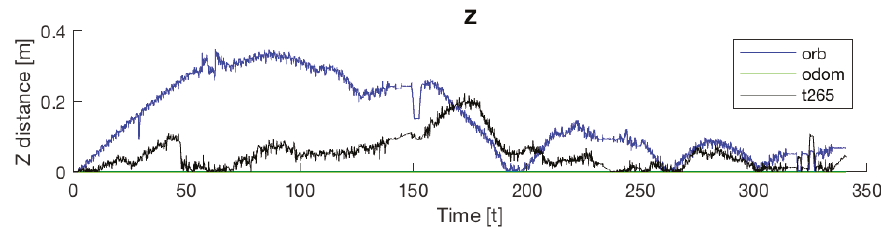
Figure 34. Outdoor circuit test on paved road. Error in Z axis.